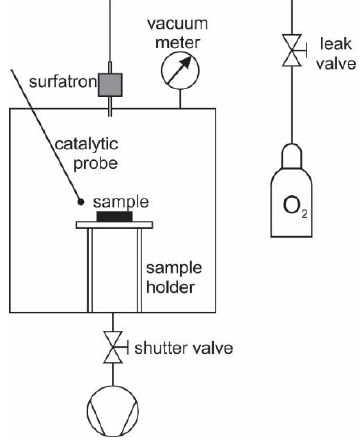
Figure 1. Experimental plasma system used for treating polymer samples.